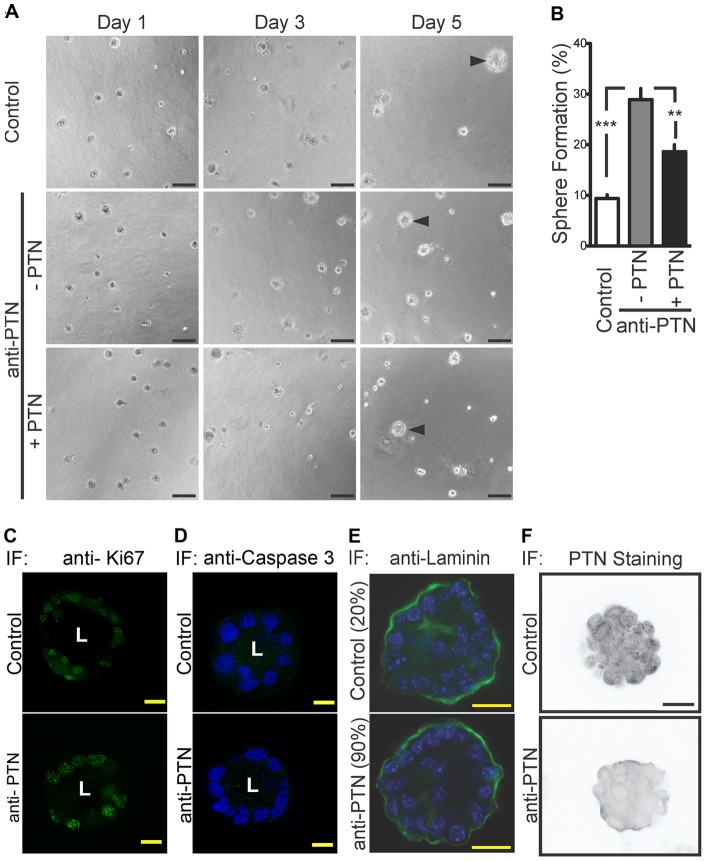
PTN effect on mammosphere formation.(A) Time course of mammosphere formation day 1, 3 and 5 without and with a blocking anti-PTN antibody ± recombinant PTN protein. Representative mammospheres that meet the threshold surface area of >900 µm2 are indicated by an arrowhead. Pictures are representative of 3 independent experiments. Scale bar  = 50 µm. (B) Quantification of mammospheres (>900 μm2 ) formed per field at day 5. Data are means ± SE; n = 5 fields/well; 4 wells for each condition. **P<0.01; versus anti-PTN treated cells; ***P<0.001 versus control by ANOVA. (C to F) Immunofluorescence of mammospheres at Day 5 for Ki67 (green)(C), Caspase 3 & DAPI (green & blue) (D), laminin & DAPI (green & blue) or for PTN (grey scale). Staining is shown in mammospheres treated with blocking anti-PTN antibody (anti-PTN) versus control. Scale bar = 20 µm.